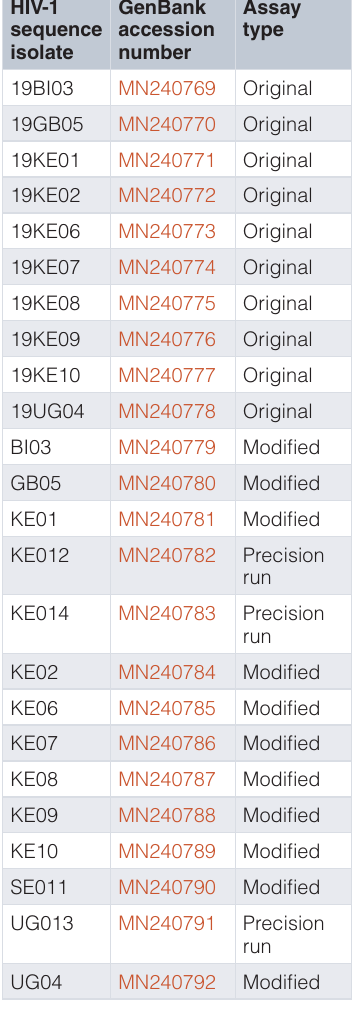
Table 7. Accession numbers of HIV-1 sequences generated in this study. HIV-1